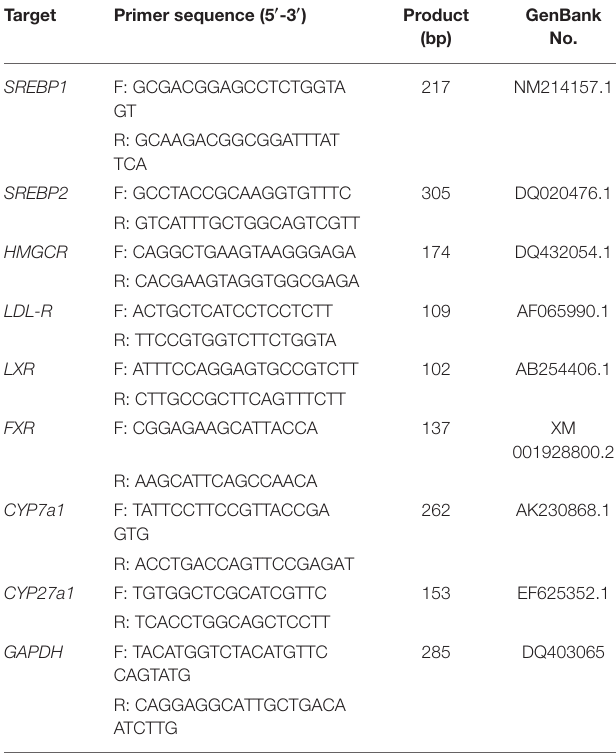
TABLE 1 | Primer sequences of the target genes. Target